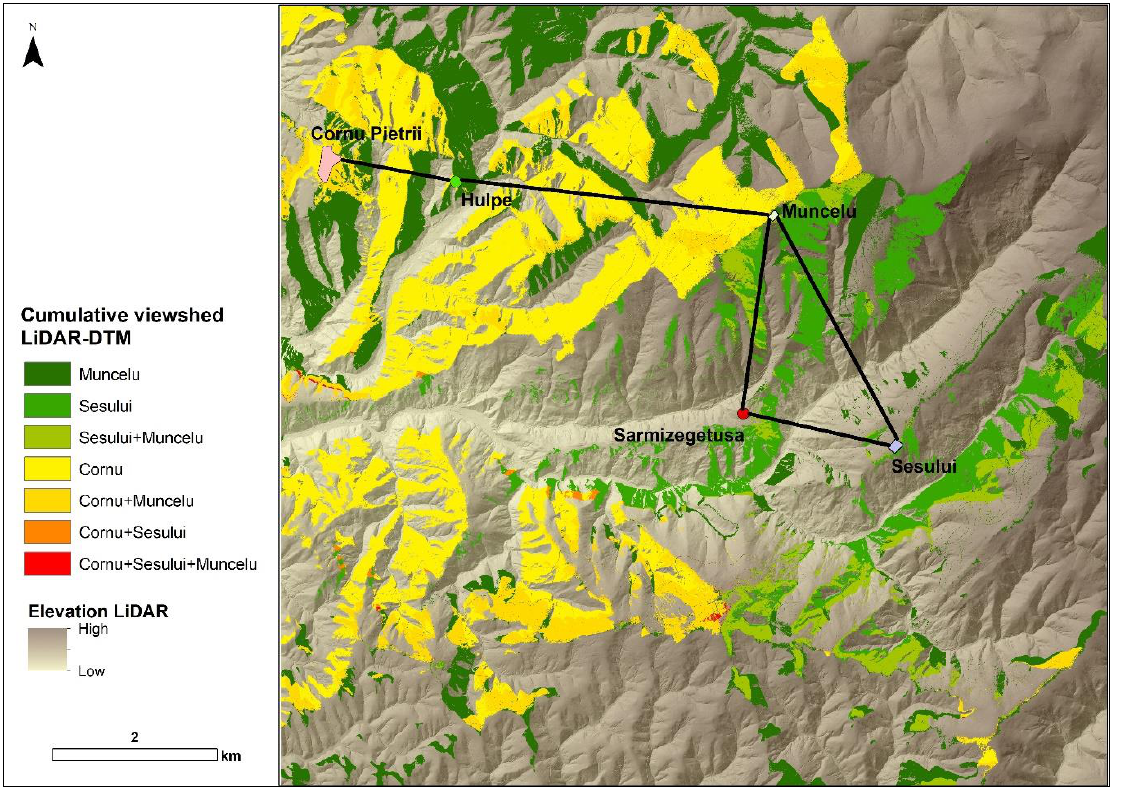
Figure 8. Cumulative view calculation and intervisibility lines from the Roman army bases in the vicinity of Sarmizegetusa Regia and Vârfu lui Hulpe Dacian hillforts.